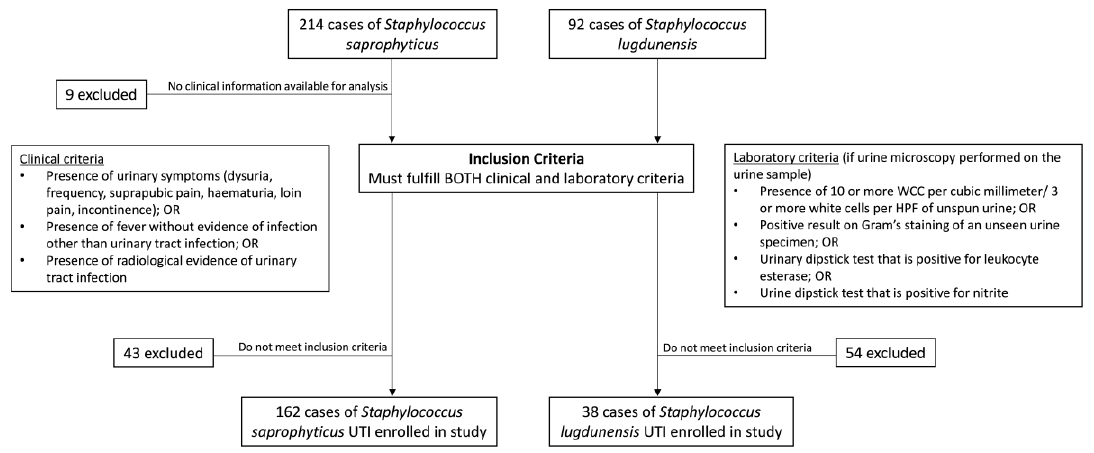
Figure 1. Enrollment flowchart of urinary tract infection (UTI) cases caused by Staphylococcus saprophyticus and Staphylococcus lugdunensis in